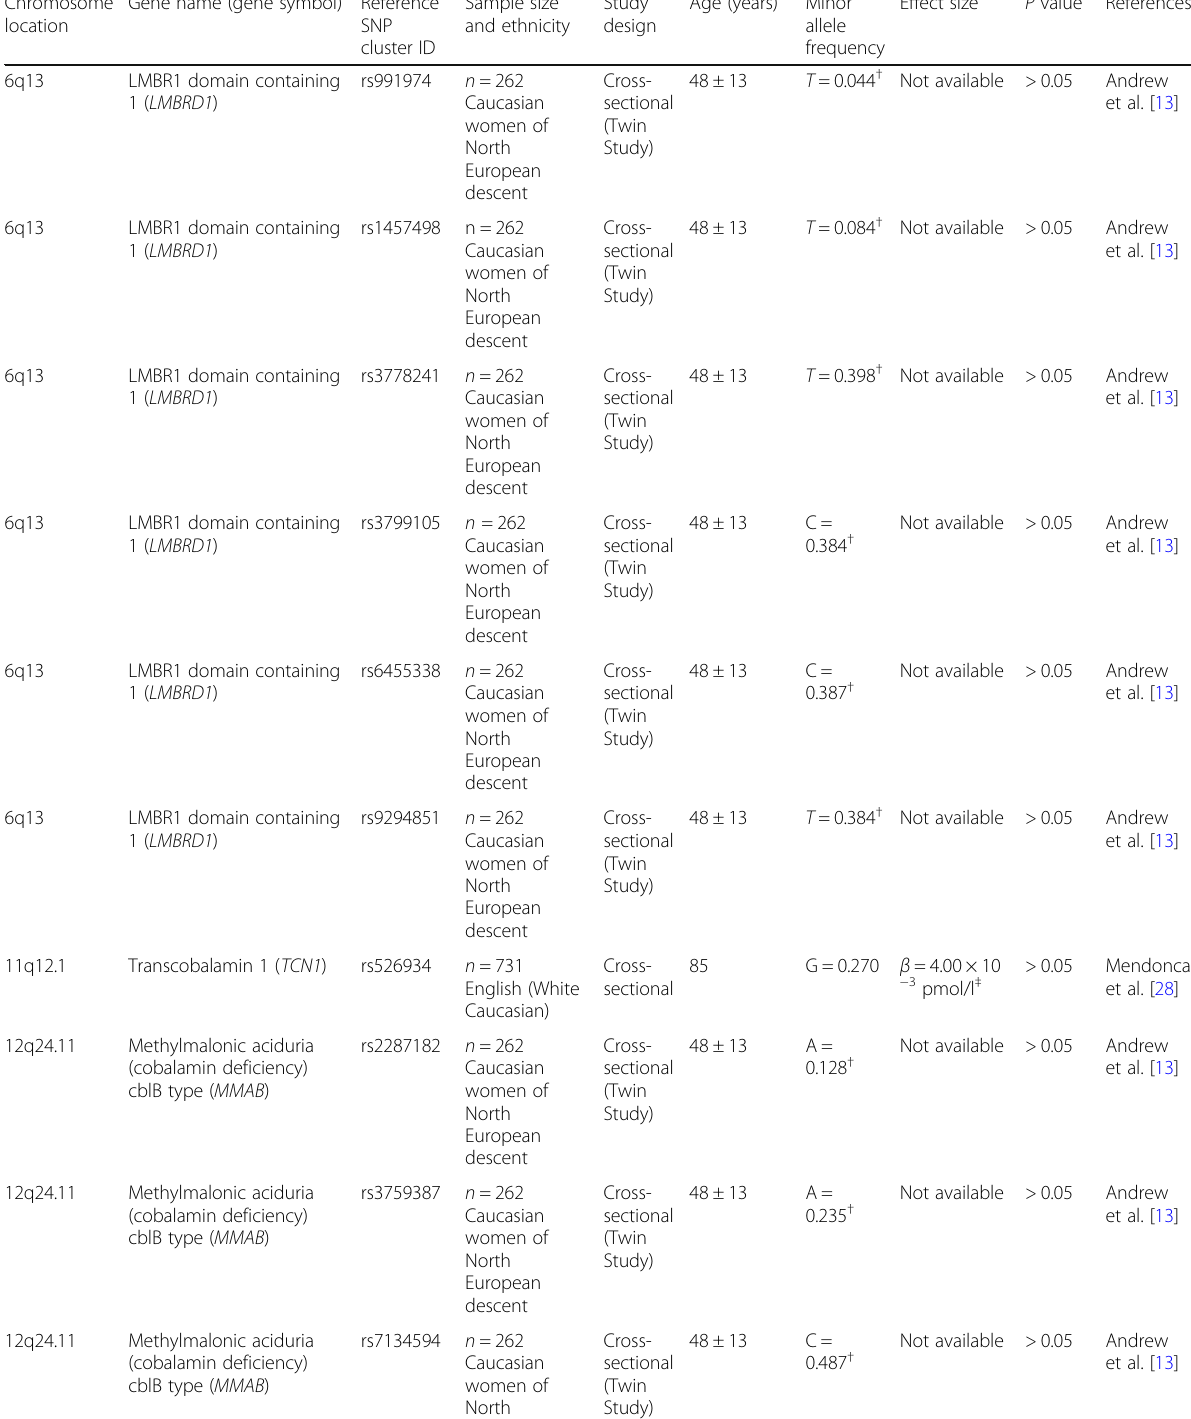
Table 2 Candidate gene association studies examining the association of SNPs with vitamin B12 concentrations. Candidate gene association studies testing the association between SNPs and vitamin B12 concentrations. The chromosome location, gene name, reference SNP cluster ID, sample size and ethnicity, study design, mean age, observed frequency of the minor allele in the population, effect size and P value are shown in the table. The order of SNPs reflects the order of the chromosome location